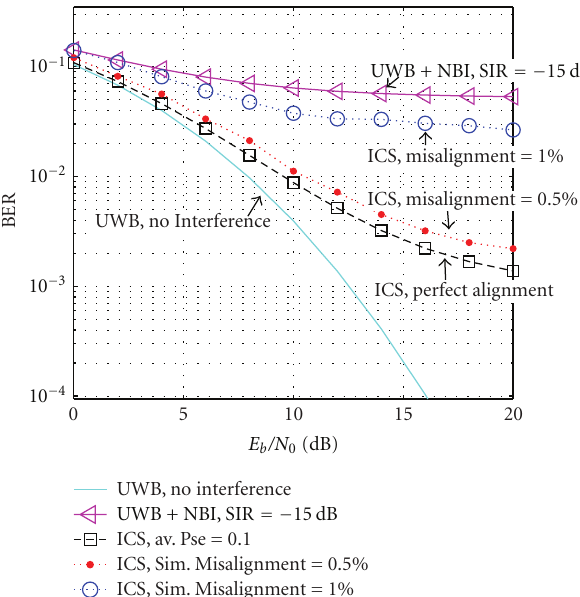
Figure 5: Timing error impact in the ICS performance, dB-spread = 2dB and SIR = − 15 dB.